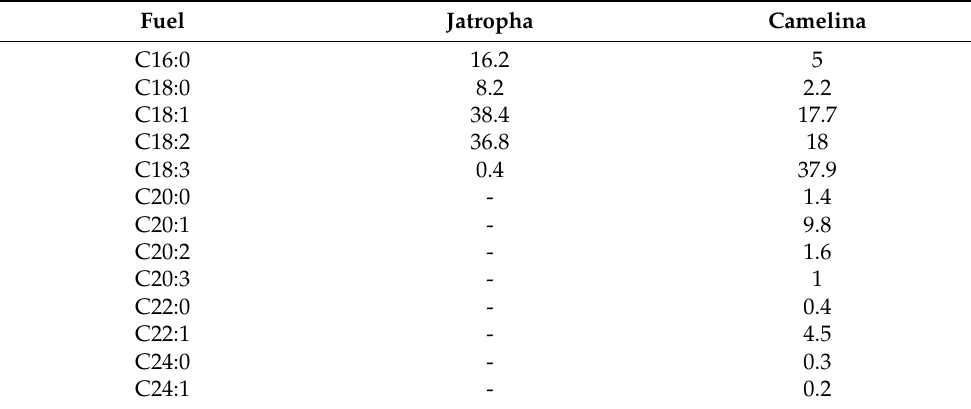
Table 5. Fatty acid fuel composition [58,70].